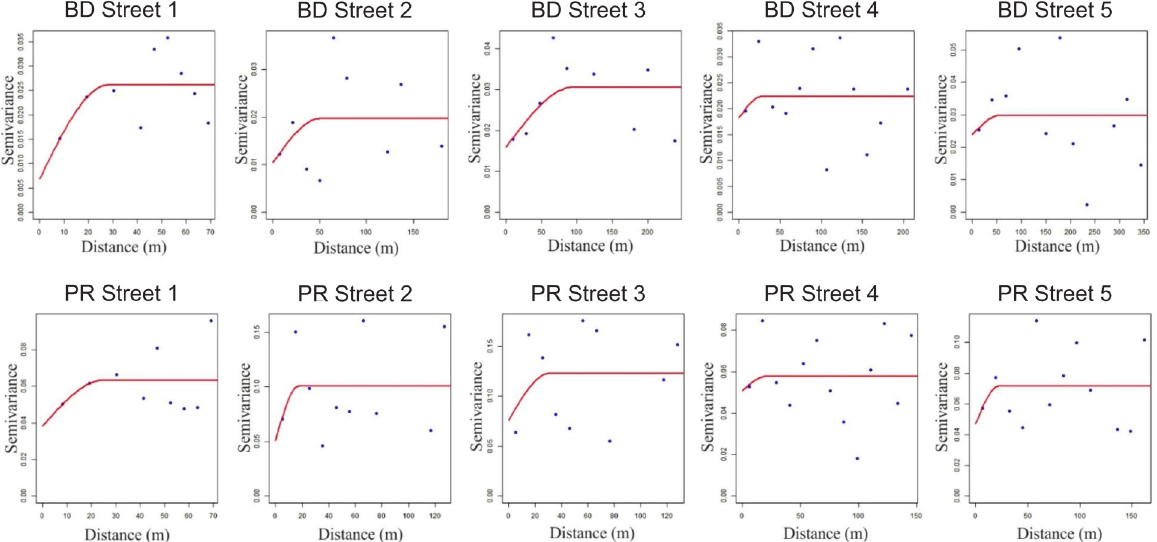
Figure 2. Semivariograms resulting from the OLS fitting aggregated with visual recognition of the spherical model structures in its relationship with the semivariances for BD and PR, per coffee